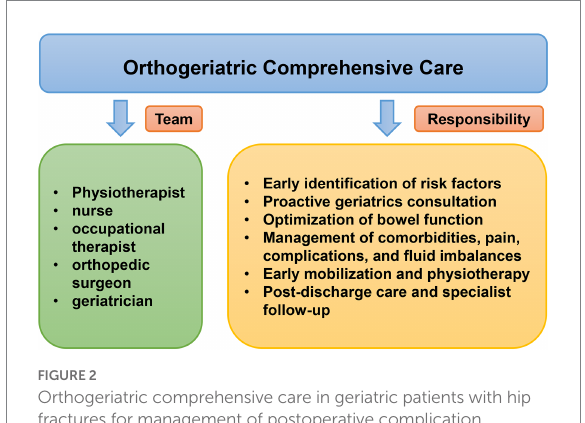
FIGURE 2 Orthogeriatric comprehensive care in geriatric patients with hip fractures for management of postoperative